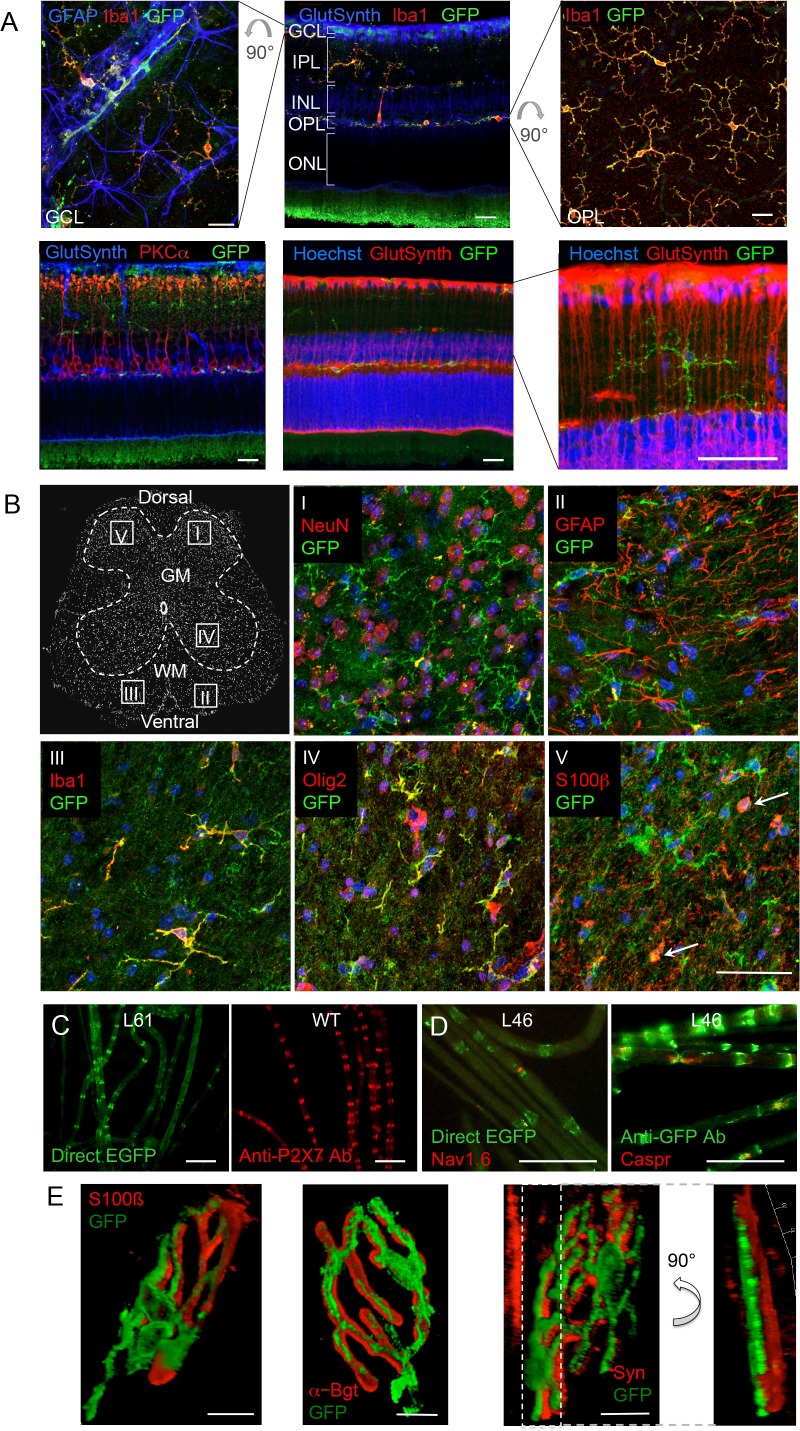
P2X7-EGFP expression in retina, sciatic nerves, spinal cord, and at the neuromuscular synapse.(A) EGFP exclusively co-localizes with microglia and endothelial cells in the adult mouse retina. Upper panel: Middle, retinal slice labeled for GFP (600 101 215, Rockland), Iba1 (marker for microglia/macrophages) and glutamine synthetase (marker for Müller glia). Left and right, retinal flat mounts scanned at the plane of the ganlion cell layer (GCL) and outer plexiform layer (OPL), respectively, to delineate microglia residing in these retinal layers. Astrocytes in the GCL were labeled with GFAP (G6171, Sigma-Aldrich). IPL, inner plexiform layer; INL, inner nuclear layer; ONL, outer nuclear layer. Lower panel: Co-staining of EGFP with neuronal marker PKCα (left) and glutamine synthetase (two right panels) at higher contrast and resolution to show absence of neuronal P2X7-EGFP. Cell nuclei were counterstained with Hoechst 33342 (blue) Scale bars: 20 µm. n = 2 individual line 61 in FVB/C57b/6 hybrid mice (B) Confocal images of GFP (ab6556, Abcam; A10262 or Thermo Fisher Scientific) co-immunostaining with antibodies against the indicated marker proteins in transgenic mice line 17 spinal cord slices (GFAP (MAB360, Millipore), S100β (S2532, Sigma Aldrich)). Representative images were taken from the areas shown in the schematic overview. Arrows indicate co-staining for S100ß and GFP. Scale bar: 40 µm. Cell nuclei were counterstained with DAPI (blue). Representative images from n = 3 animals are shown. (C) Comparison of transgenic P2X7-EGFP fluorescence and endogenous P2X7 immunofluorescence (P2X7 antibody, Synaptic Systems) in teased sciatic nerve fibers of line 61 and wt mice, respectively. Representative images from at least 3 animals are shown. (D) Co-staining of P2X7-EGFP (A11122, Thermo Fischer Scientific, dilution 1:1000) in teased sciatic nerve fibers of line 46 with antibodies against axonal marker proteins demonstrates localization of the transgene at perinodal regions of Schwann cells. Scale bars: 50 μm. (E) Reconstructed 3-D images of the neuromuscular junction showing co-staining of P2X7-EGFP (ab6556, Abcam; or A10262, Thermo Fisher Scientific) with perisynaptic Schwann cells (S100β (S2532, Sigma Aldrich)) as well as postsynaptic (α-Bungarotoxin, α-Bgt) and presynaptic (synaptophysin, Syn) marker proteins. The side view in the right panel shows no overlap between GFP and synaptophysin staining. Scale bars: 10 µm and 20 µm, respectively. Representative images from n = 3 animals are shown. For antibodies not specified in the legend see Key resources table.